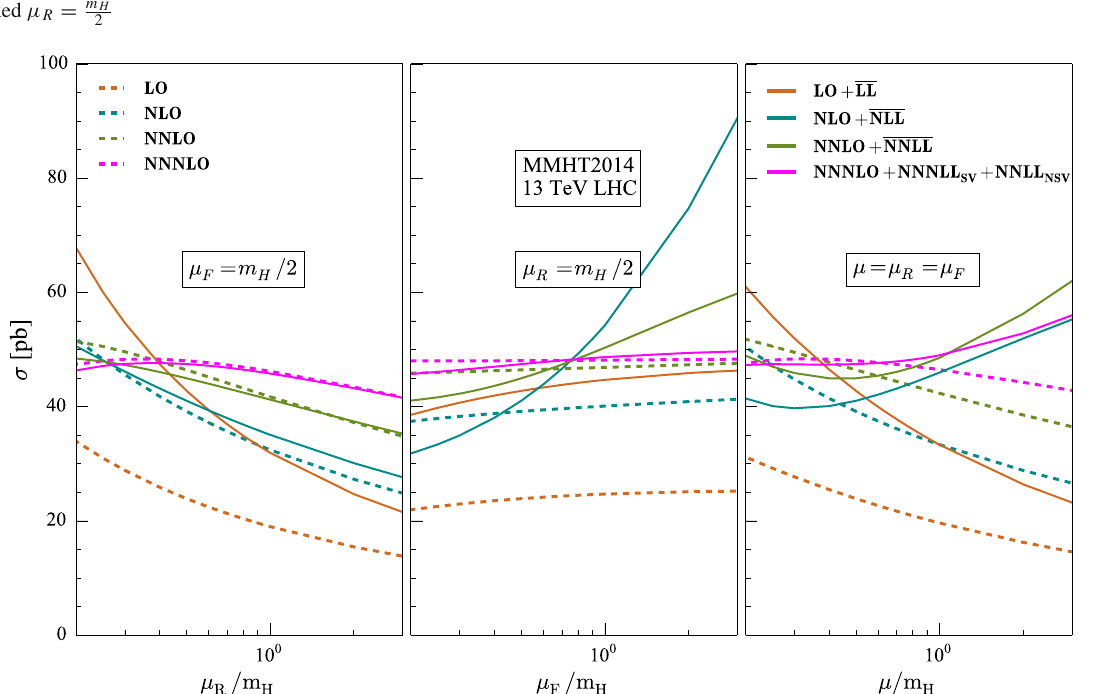
Fig. 2 Scale variation of the resummed results against the fixed order w.r.t the renormalisation scale( μ R ) in the first panel, factorisation scale( μ F ) in the second panel and μ R = μ F = μ in the third panel at 13 TeV